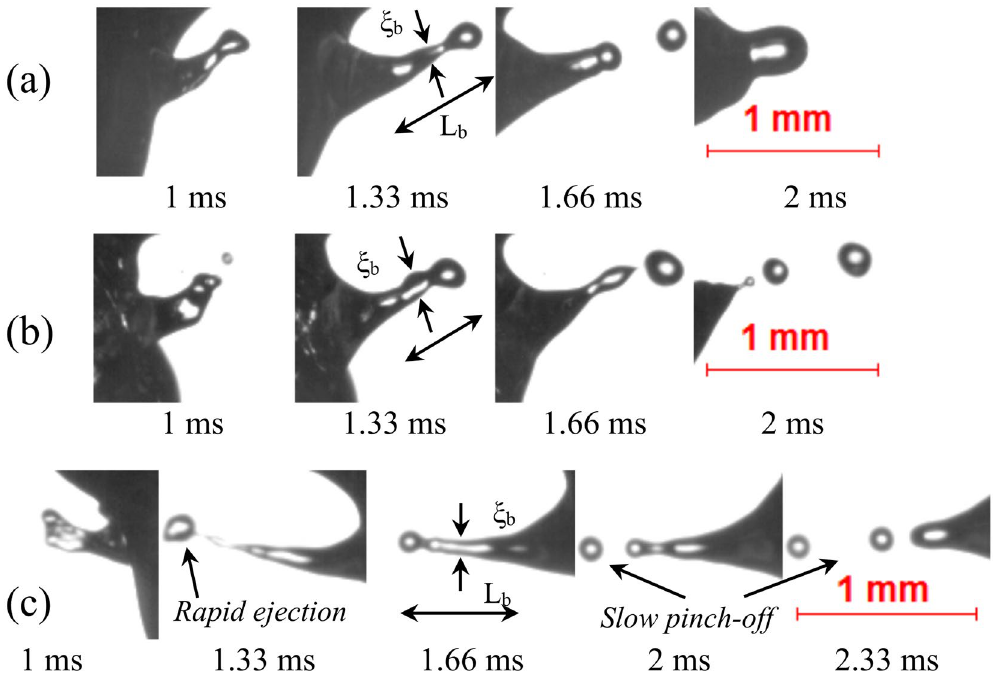
Figure 3. Low momentum ligament growth with ( a ) tip breakup ( α = 0.2, AR = 6.8) in B30 droplet, ( b ) tip-base breakup ( α = 0.2, AR = 3.96) in E30 droplet, and ( c ) formation of multiple secondary droplets in E30 droplet ( α = 0.43, AR = 5.7). The maximum velocity of the secondary droplets is O (1